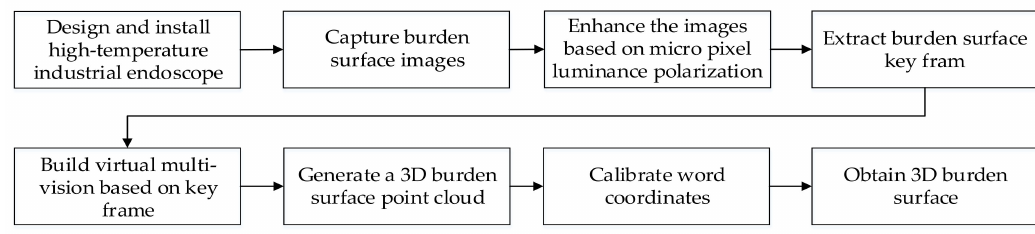
Figure 1. Block diagram of 3D full burden surface measurement